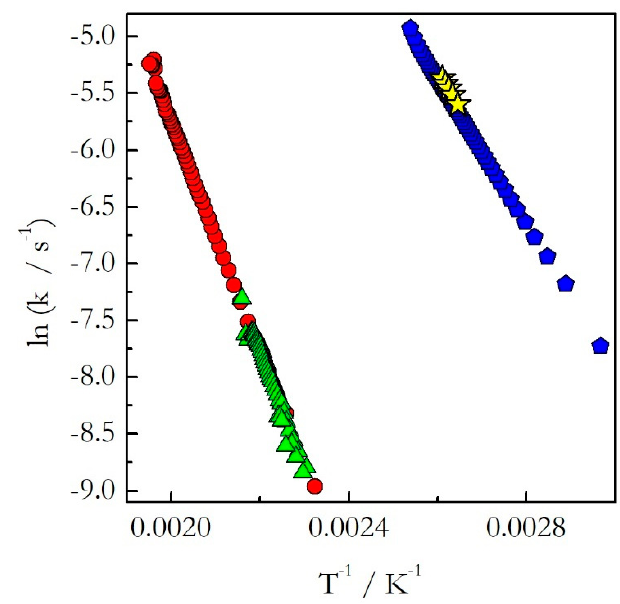
Figure 4. The rate constant as a function of reciprocal temperature for the thermal decomposition of AN (heating (red circles) and cooling (green triangles)) and nonstoichiometric polymerization of DGEBA and m-PDA (heating (blue pentagons) and cooling (yellow stars)) evaluated on heating and cooling. Adapted from Ref. [23] with permission from Elsevier.